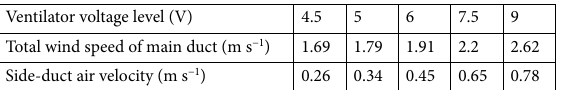
Table 2. Downstream ventilation fan voltage and corresponding wind